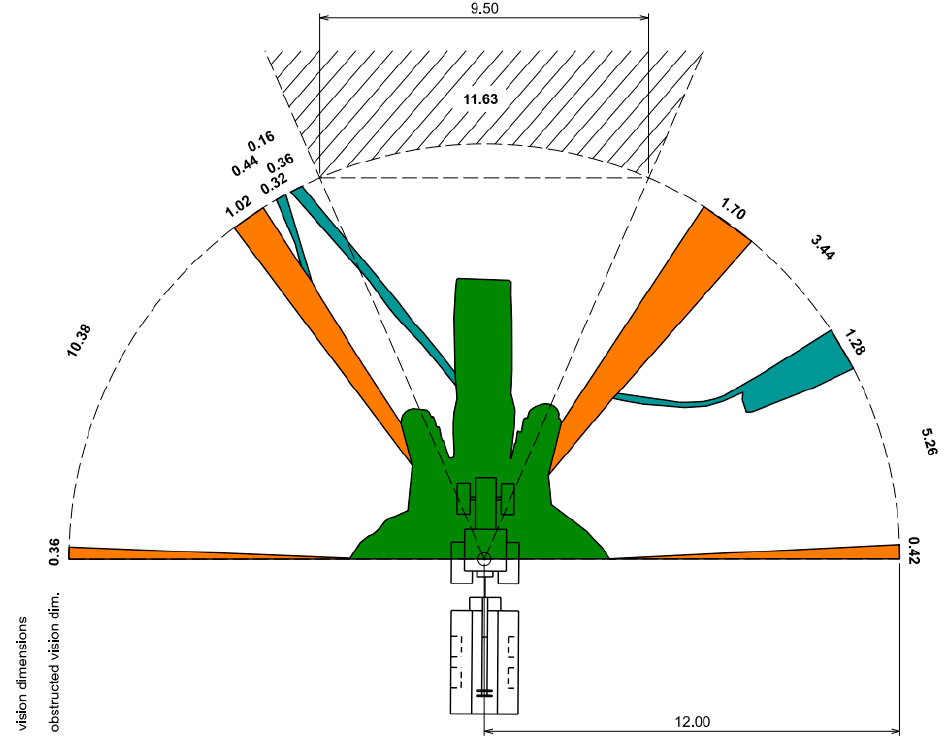
Figure 3. Graphical evaluation of the semicircular field of forward view from the cabin of tractor Valtra T 6300.